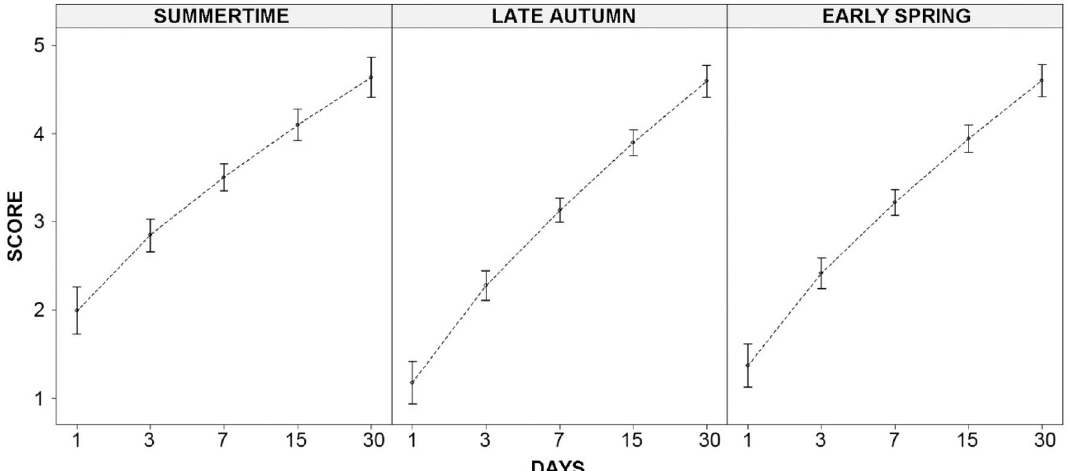
Figure 1. Decomposition scores of large-sized birds (i.e., hens) throughout time (five sampling events at days 1, 3, 7, 15 and 30 after the fresh carcasses were placed in the field) in three different seasons. The vertical bars show the average ± 95% confidence intervals of the data pooled for the two islands (the main effect of island, and the interactions between Island and the other two factors were not significant; see Table 2 for more